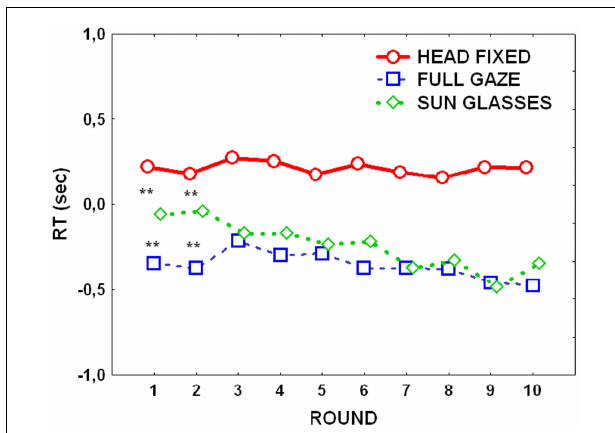
FIGURE 9 | Reaction time (RT) over the rounds. In initial rounds Head Fixed > Sun Glasses > Full Gaze. Later, this becomes Head Fixed > Sun Glasses = Full Gaze, indicating that subjects learn to “read” the gaze from head position of the robot.